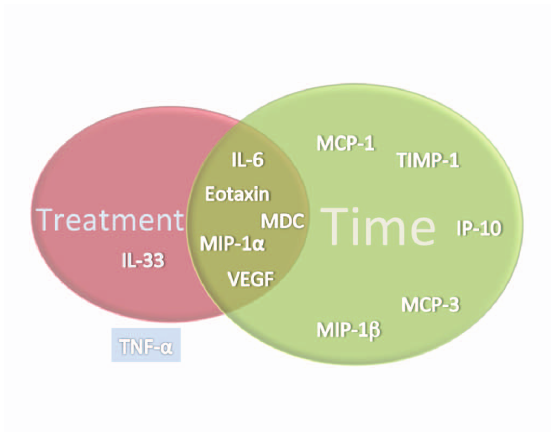
Figure 2. Venn diagram depicting the relationship between variation of plasma cytokine levels and the variables of time and treatment. MCP-1, TIMP-1, IP-10, MCP-3 and MIP-1 b vary differently across the different timepoints sampled, but are have similar variance between treatment groups (RT alone vs ChemoRT). IL-6, Eotaxin, MDC, MIP-1 a and VEGF levels varied across both time and treatment group. TNF- a levels were no different across time points sampled or treatment delivered.